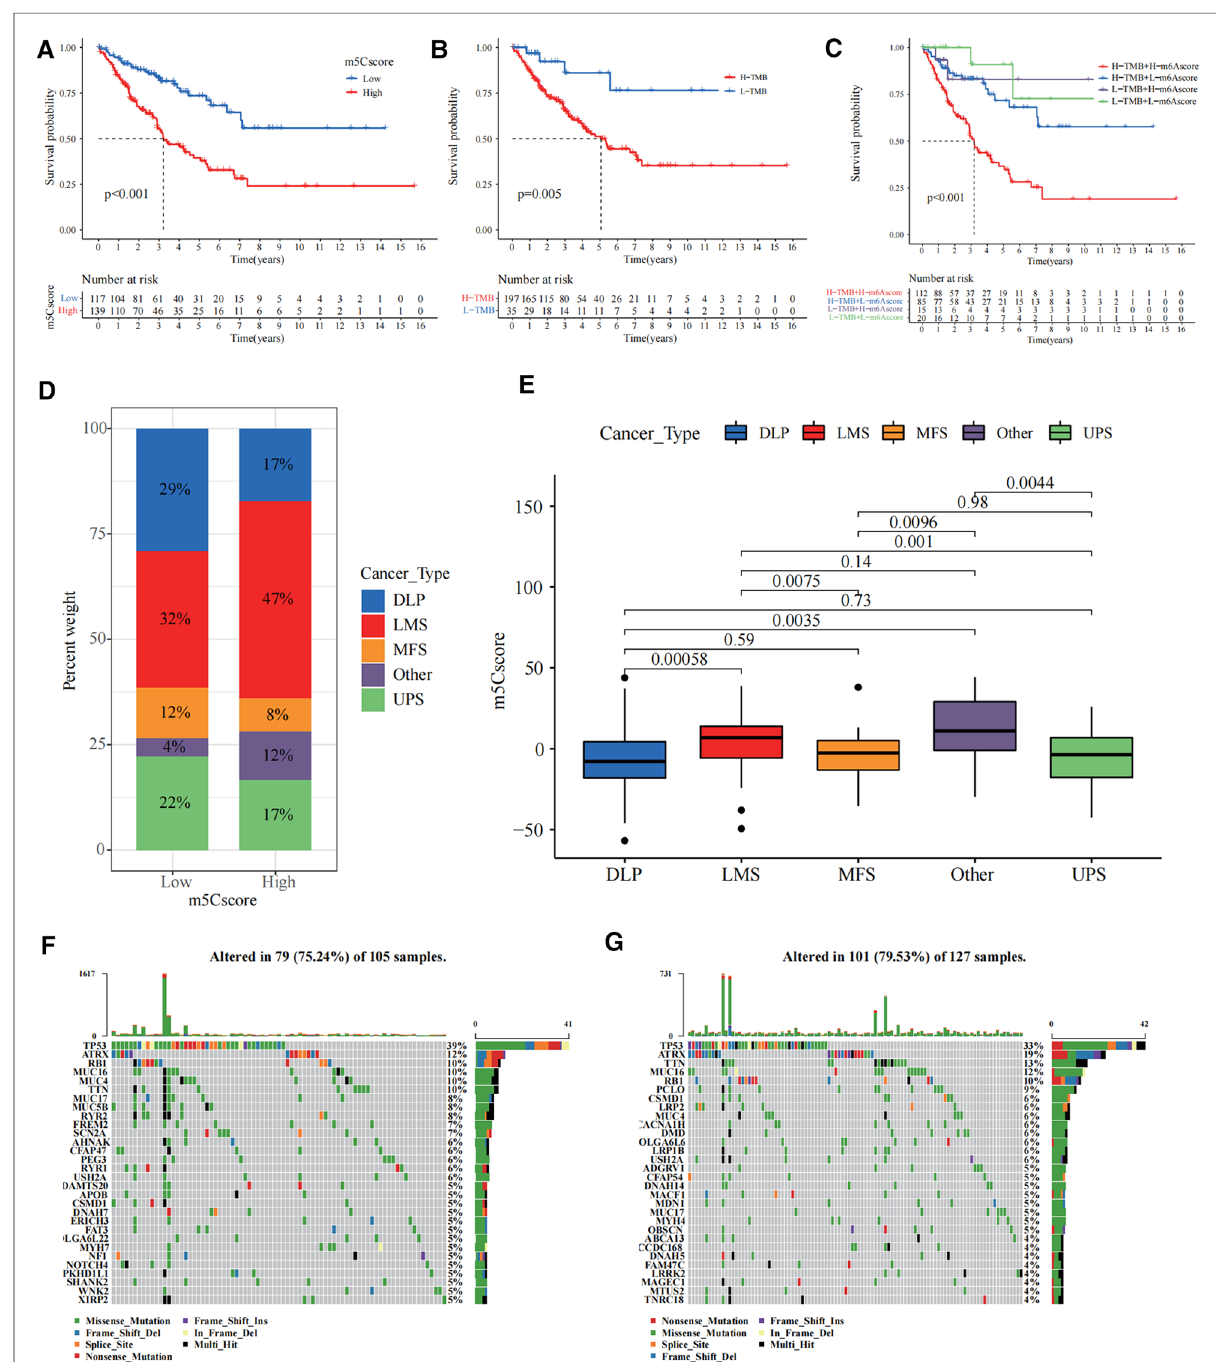
FIGURE 4 Construction of the 5-methylcytosine (m5C) score and relevance of its clinical features. ( A ) The survival curve showed that the high m5C score group had a worse prognosis ( p <0.001). ( B ) The survival curve showed that the high tumour mutation burden (TMB) score group had a worse prognosis ( p =0.005). ( C ) Combining the m5C score and TMB score, we found that the group with high m5C and TMB scores had the worst prognosis. ( D ) The bar chart shows the percentage distribution of different sarcoma subtypes in the high and low m5C scoring subgroups. ( E ) Distribution of the m5C score in the different sarcoma subtypes. The differences between every two groups were compared through the Kruskal – Wallis H test. ( F,G ) The waterfall plots illustrate the differences in somatic mutations between the high (right) and low (left) m5C score